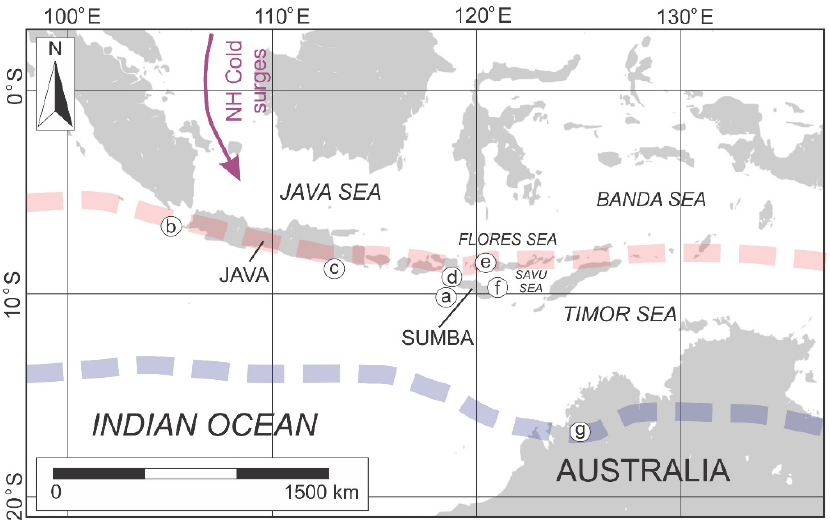
Figure 9. The southern limit of the austral summer ITCZ during the drier (lower rainfall) periods (red dashed line) and during the wetter (higher) rainfall periods (blue dashed line) as suggested by this study and other previous studies [8,11,100,101]. Numbers show the location of ST08 (( a ), this study) and other studies used for comparison i.e., GeoB10043-3 ( b ) [10], GeoB10053-7 ( c ) [1], GeoB10065-7 ( d ) [2], Liang Luar cave (Flores) ( e ) [16], GeoB10069-3 ( f ) [28,72], and Bali Gown cave